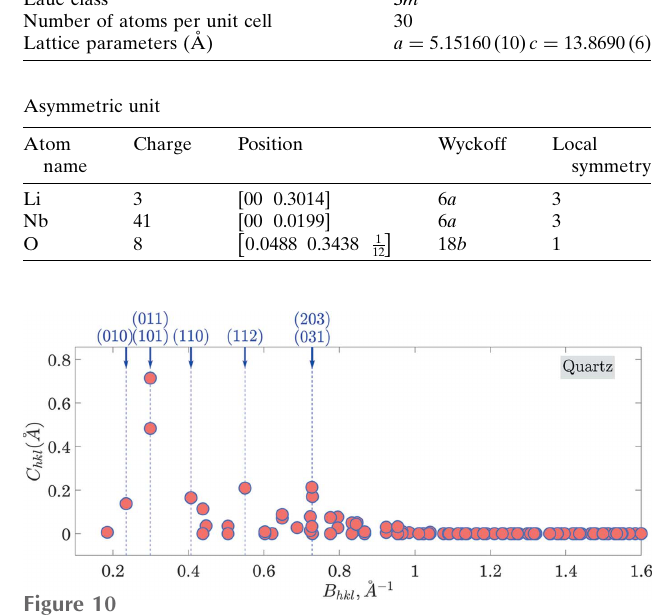
vectors. Figs. 11 and 12 illustrate the anisotropy of C stereographic projections along [100] and [001] zone axes [defining the normal to X and Z cuts of quartz wafers (Brai- nerd et al. , 1949)]. Table 5 lists the numerical values of C seven planes with the most prominent gaps. Figs. 13 and 14 Uriel Vaknin et al. (cid:5) Geometrical prediction of cleavage planes in crystal structures